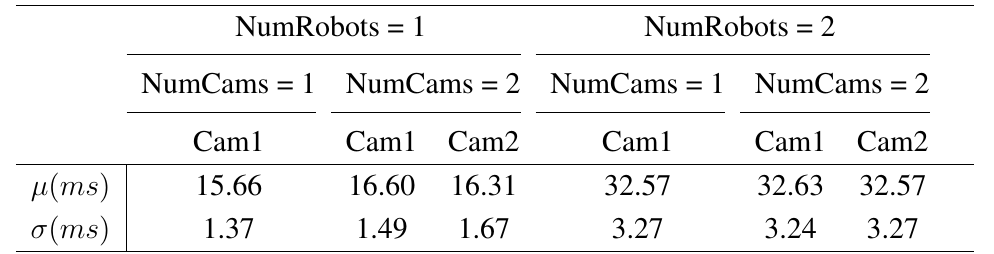
Table 4. Execution times of the robot detection and tracking algorithm. µ is the average processing time per image (in milliseconds), and σ is the standard deviation (in milliseconds). NumRobots refers to the number of different robots that the algorithm tries to detect. NumCams refers to the number of camera-agents executed on a single computer